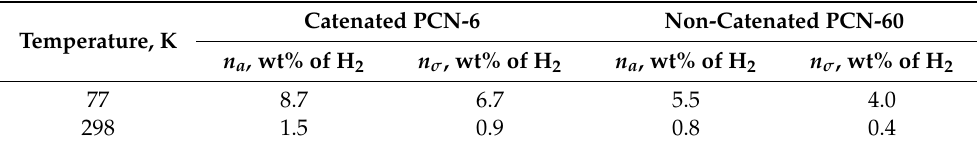
Table 3. Values of surface excess and the total adsorbed amount of hydrogen (experimentally obtained at 77 or 298 K and 50 bar of H 2 ) for catenated PCN-6 and non-catenated PCN-60. Catenated PCN-6 Non-Catenated PCN-60 Temperature, K n a , wt% of H 2 n σ , wt% of H 2 n a , wt% of H 2 n σ , wt% of H 2 77 298 1.5 0.9 0.8